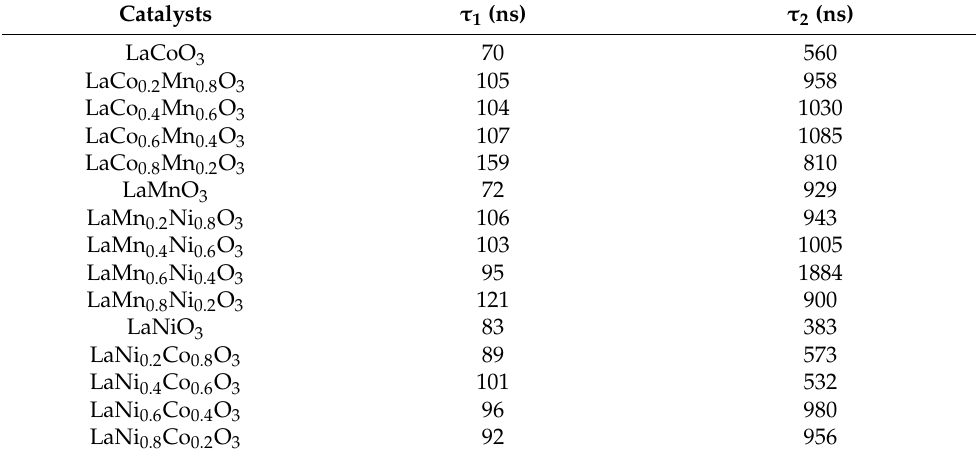
Table 1. The lifetime of LaCo x Mn 1 − x O 3 , LaMn x Ni 1 − x O 3 and LaNi x Co 1 − x O 3 (x = 0, 0.2, 0.4, 0.6, 0.8 and